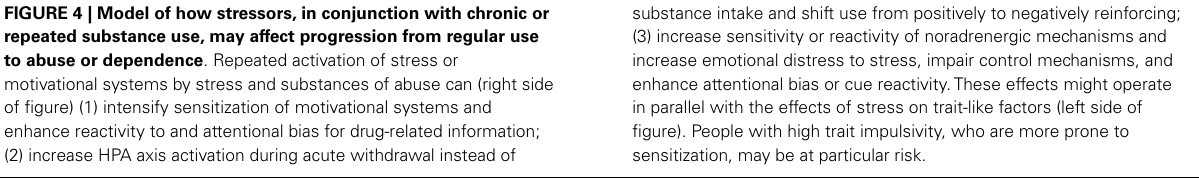
Table 1 | Relationships between childhood trauma and stages of addictions divided by substance class